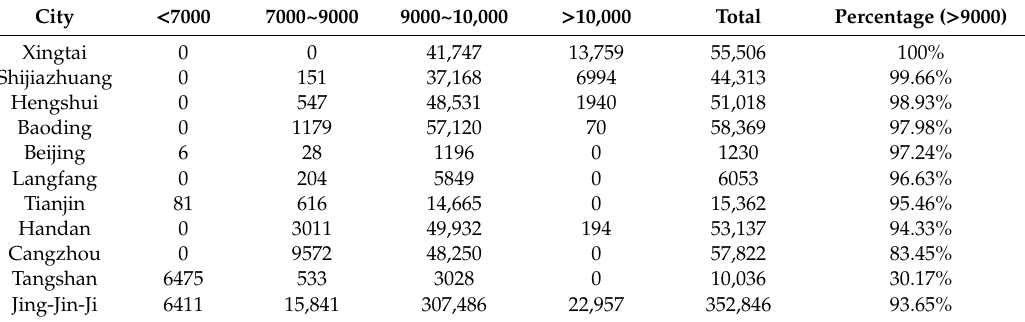
Table 8. Statistics of the production potential of winter wheat in each